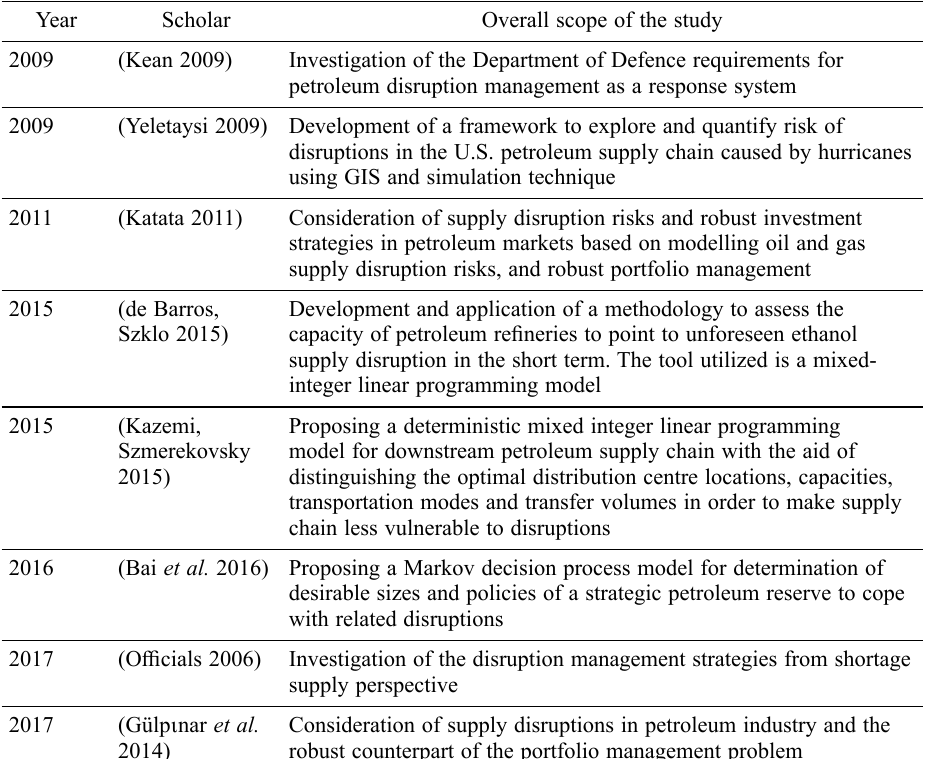
Table 2. Some of studies related to disruption management in petroleum supply